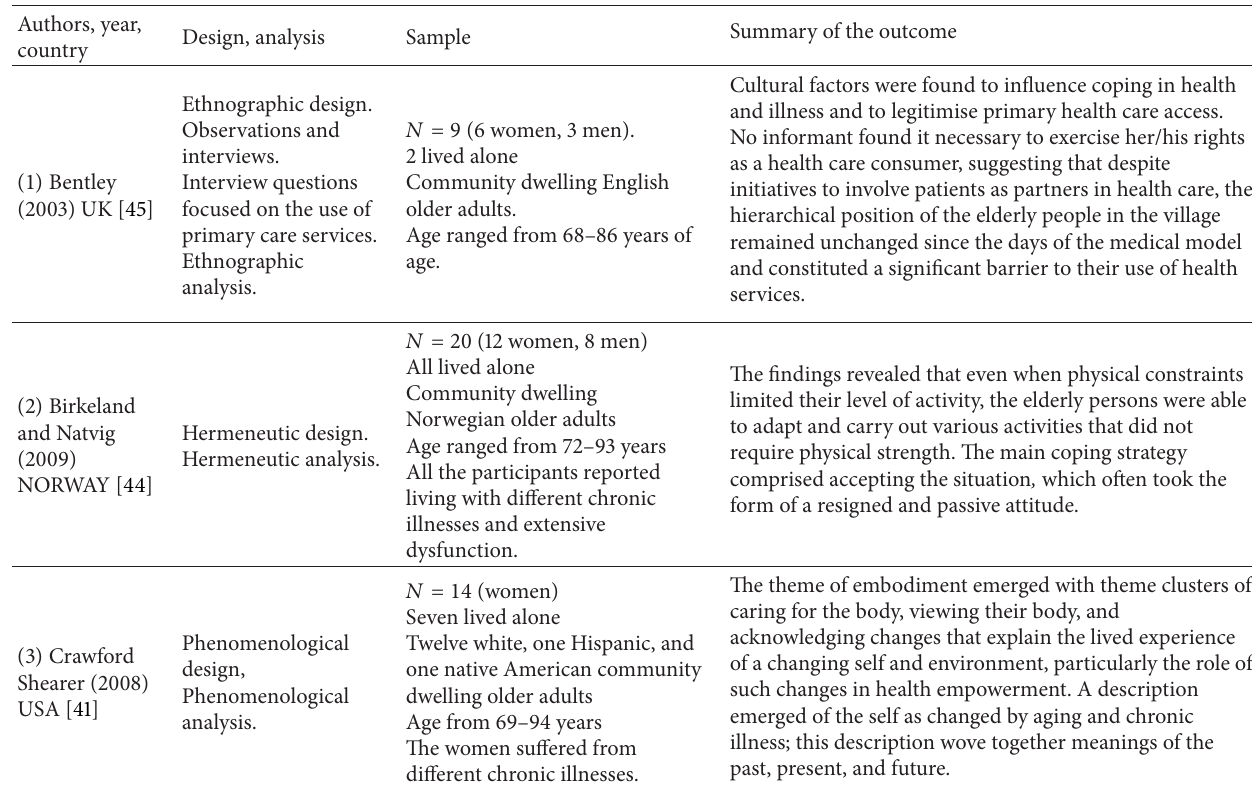
Table 1: Studies included in the qualitative systematic review of health and ill health among old persons’ in need of health care. Authors, year,